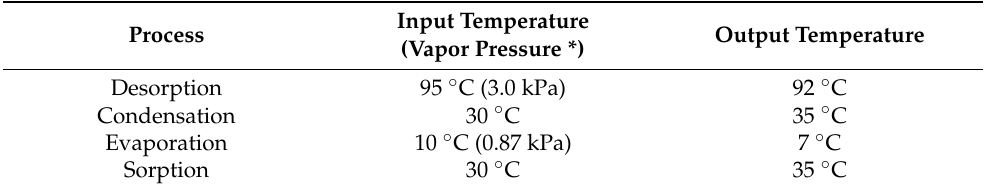
Table 2. Temperature guideline for uniform sorption thermal storage testing for space heating in